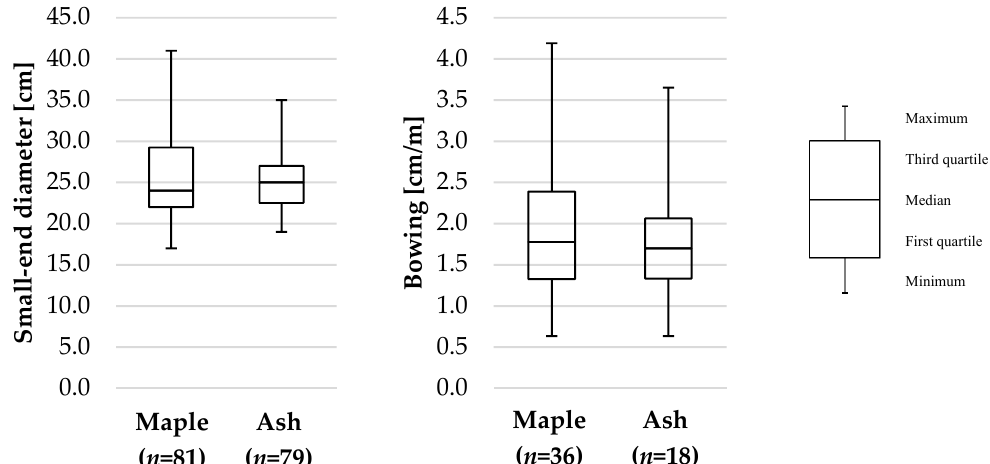
Figure 4. Boxplots for log section small-end diameter and bowing (only in one direction according to RVR instructions) separated after species ( n = number of log sections).